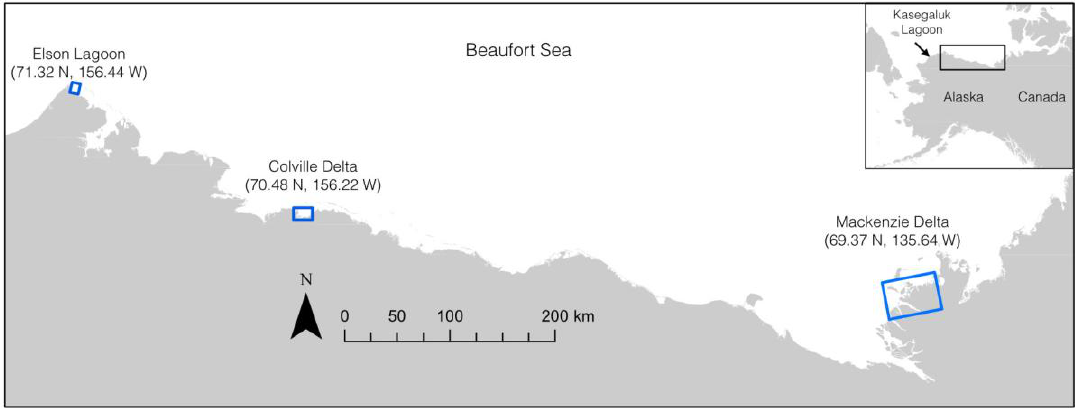
Figure 2. Overview map of three study areas on the Beaufort Sea coast.